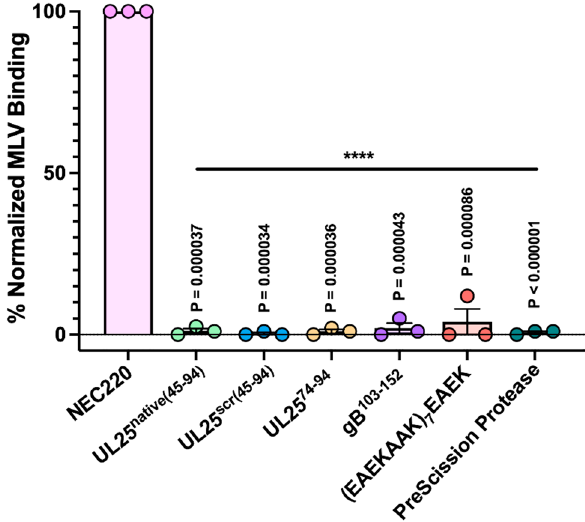
Figure 4. Peptides do not bind synthetic liposomes. NEC but not peptides bind multilamellar vesicles (MLVs) of the same composition as the GUVs used in the in-vitro budding assay. PreScission protease, which does not bind membranes, was used as a negative control. Each experiment was done in three biological replicates, each consisting of two technical replicates. Symbols represent average binding efficiency of each biological replicate relative to NEC220 (100%). Bars show the mean of three biological replicates, with error bars representing the standard error of the mean. Significance compared to NEC220 was calculated using an unpaired t -test. **** P value <